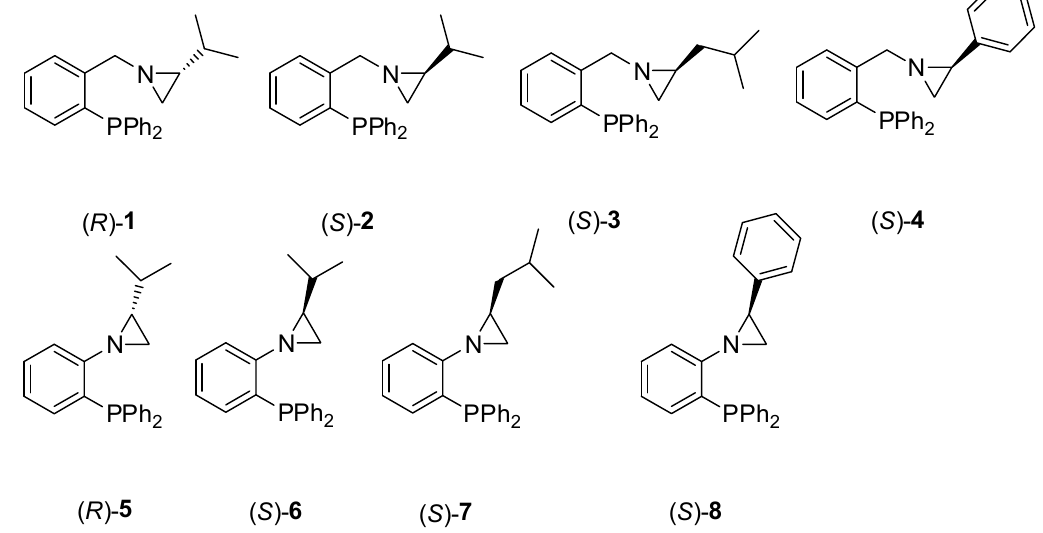
Figure 1. The structures of chiral aziridine-phosphines 1 – 8 .